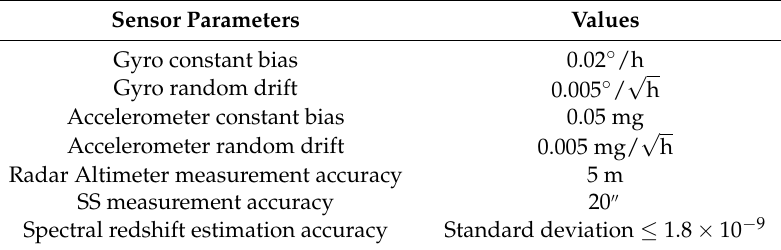
Table 2. The sensor parameters in the simulation test.